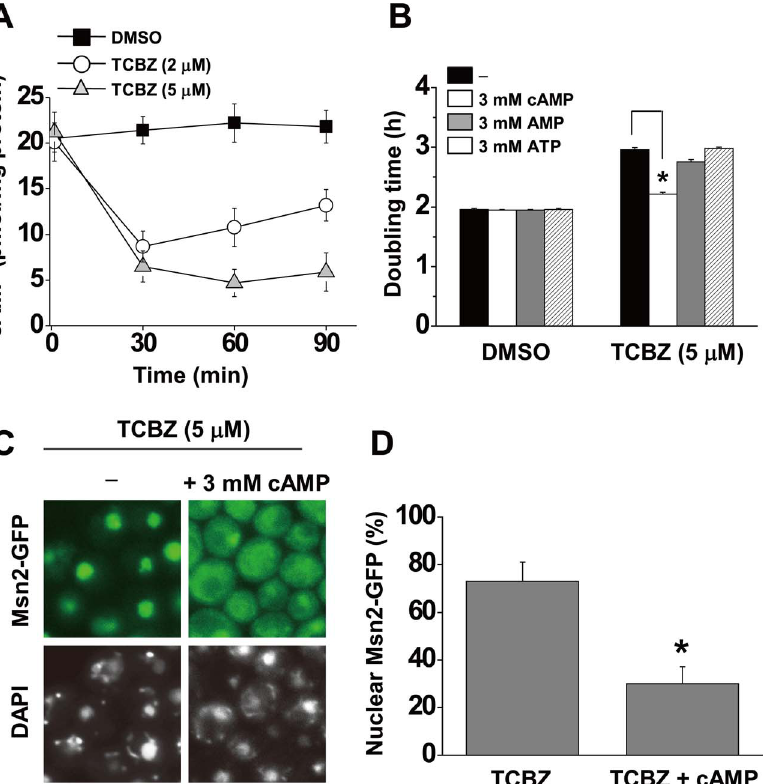
Figure 6. Triclabendazole decreases intracellular cAMP. (A) Intracellular level of cAMP. Cells (wild-type) were inoculated in SC-glucose medium and grown to mid-log phase, drug was added, and the samples were incubated for the indicated times. cAMP was extracted from cells and quantified using an immunoassay (Cell Signaling). Values are the mean 6 SD of the four independent experiments. (B) Doubling time. Cells (wild- type) were inoculated into SC-glucose containing triclabendazole (5 m M) or DMSO with added nucleotide (cAMP, AMP or ATP) and incubated with shaking at 30 u C. Doubling times are the mean 6 SD of the three independent experiments. *, p , 0.005. (C) Msn2-GFP localization. Cells expressing Msn2-GFP were grown to mid-log phase, and then triclabendazole (5 m M) or triclabendazole (5 m M) and cAMP (3 mM) was added. The cells were imaged by fluorescence microscopy after 2 h. (D) Percent of cells with nuclear-localized Msn2-GFP. Values are means 6 SD from two independent experiments, where the total number of cells counted was 200–300. *, p , 0.005.